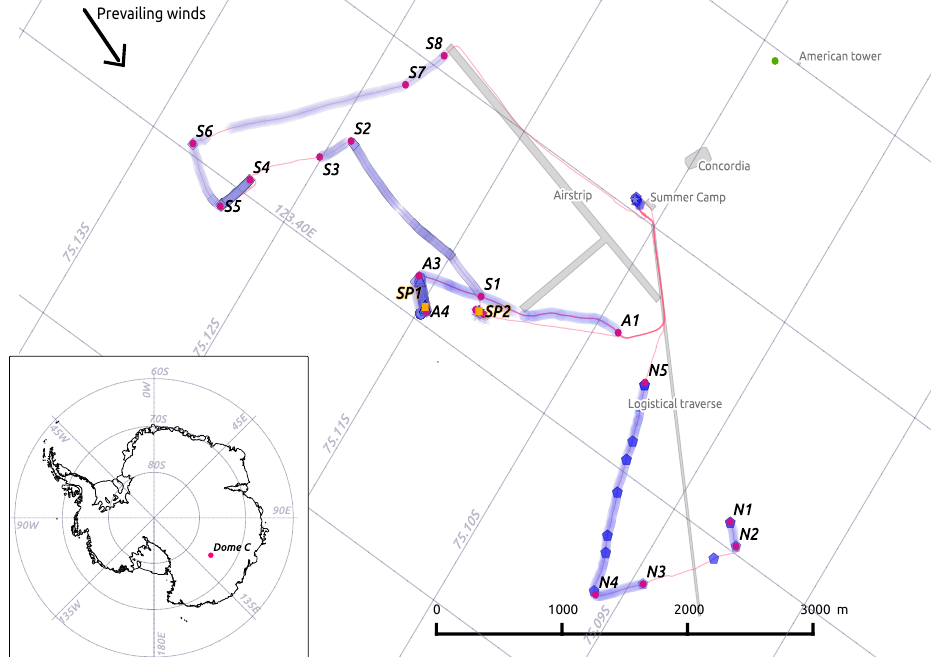
Figure 1. Location of the experiment in January 2012. The semi-transparent blue symbols represent the individual measurements. The letter and number labels identify points along the transects used for reference. SP1 and SP2 are the locations where detailed snow property mea- surements were collected to run the DMRT-ML microwave emission model. The green point identifies the location of the snow temperature